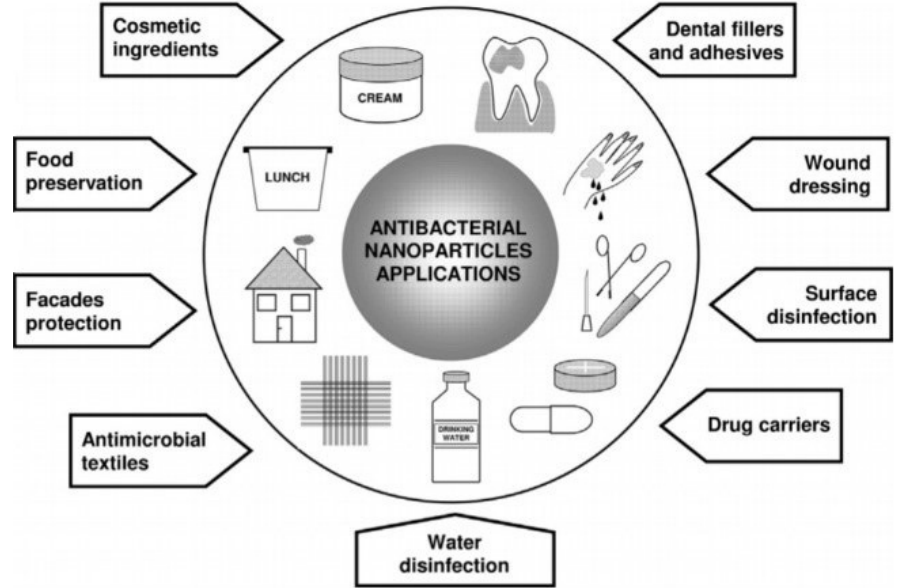
Figure 4. Antibacterial nanoparticles applications [84].